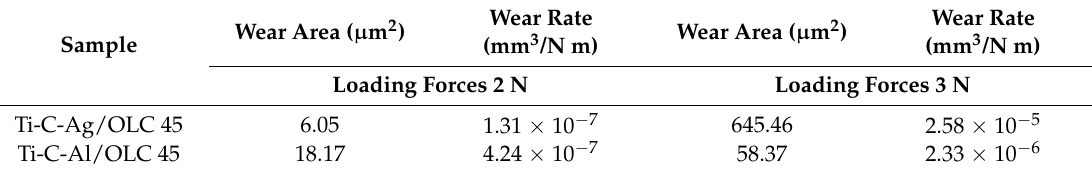
Table 2. Area and wear rates of thin films.